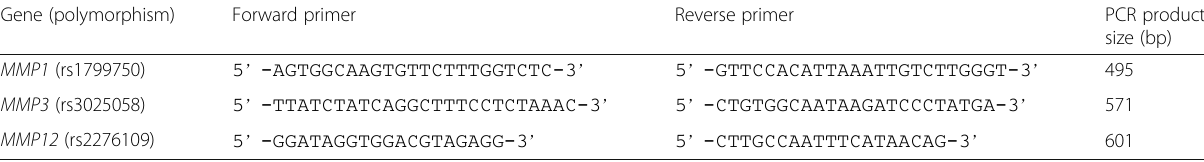
Table 1 PCR and sequencing primers for the polymorphisms Gene (polymorphism)